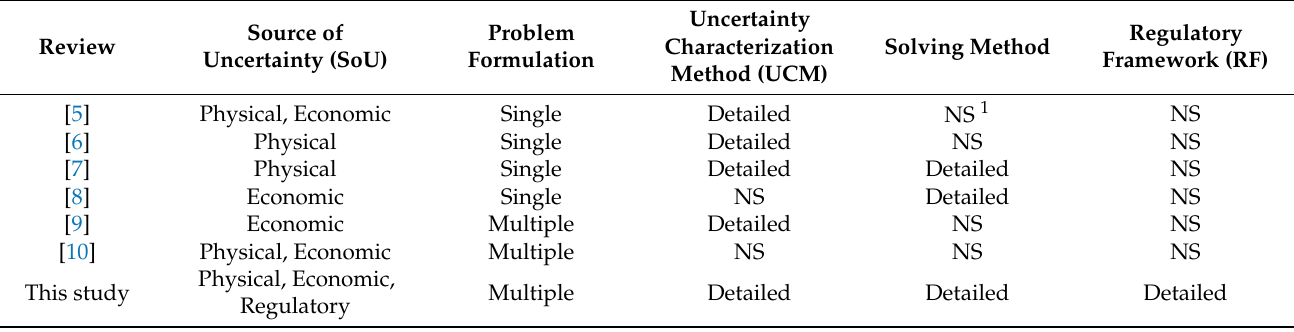
Table 1. Literature review summary and contributions of this